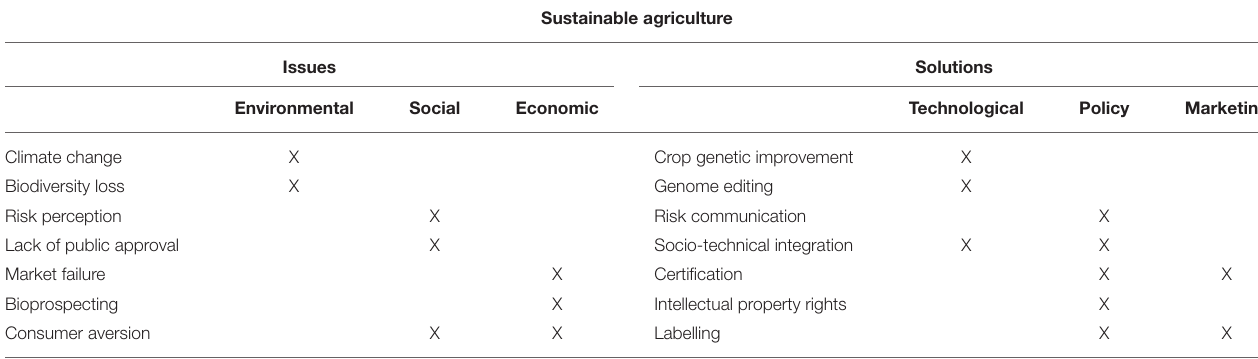
TABLE 1 | Framework for analysing the ways in which biotechnology is hypothesised to contribute to sustainable agriculture. Sustainable